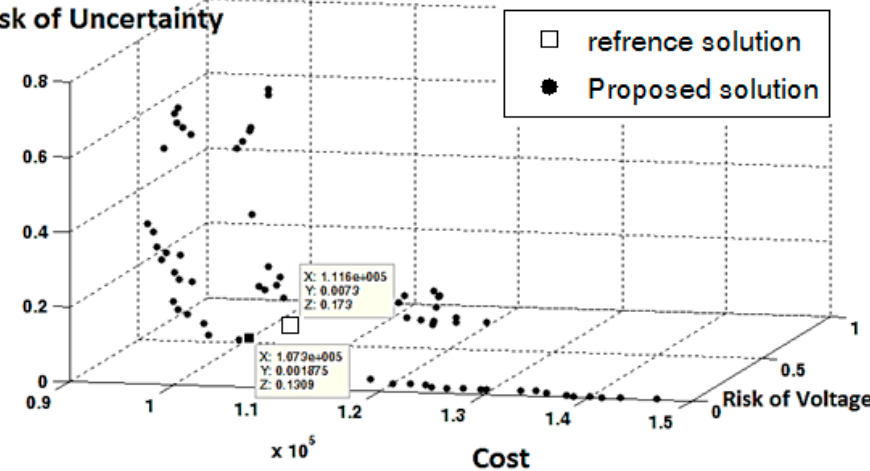
Figure 15. Comparison of reference [29] response with the Pareto Front obtained from fixed capacitor placement.